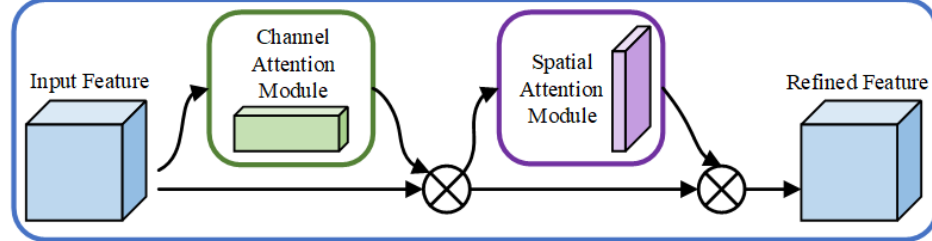
Figure 4. The structure of CBAM, reprinted with permission from Ref. [21]. 2018, Spring Nature.